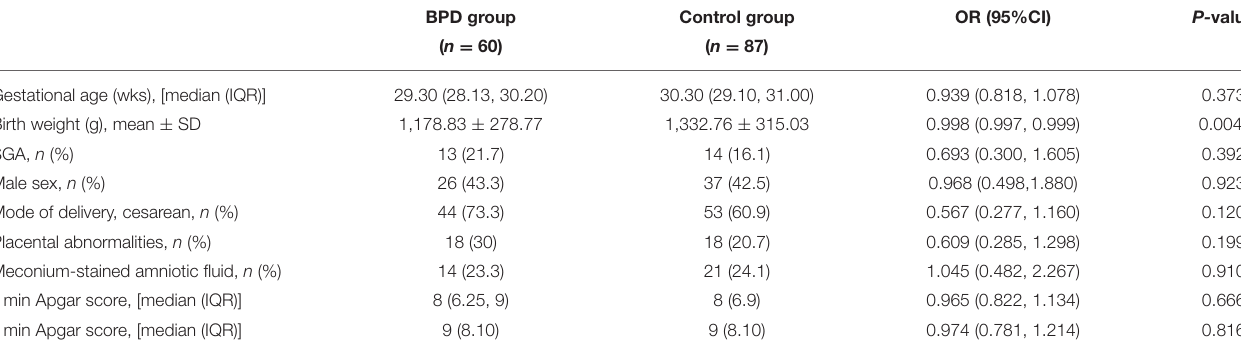
TABLE 1 | Demographic and delivery characteristics of the controls and infants with BPD. BPD group Control group OR (95%CI) P-